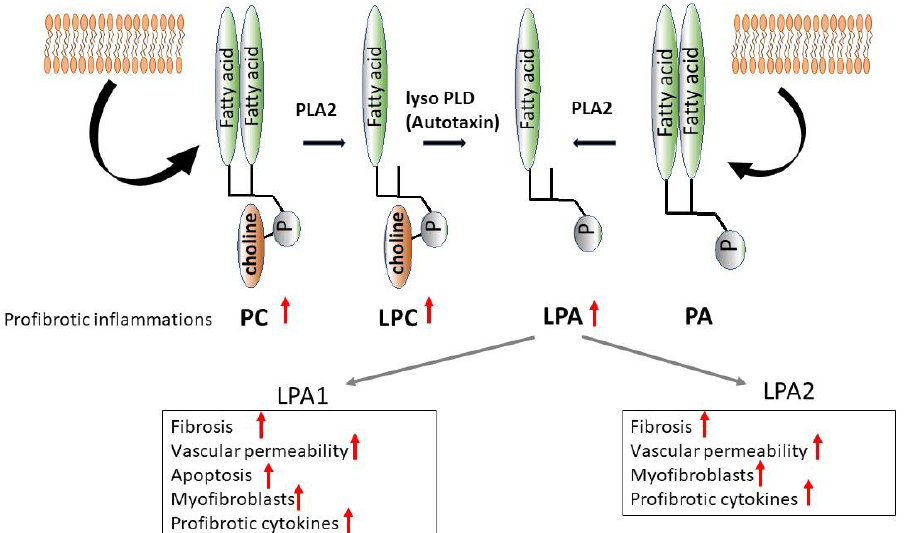
Figure 3. LPA pathway in fibrotic lung diseases. A representative pathway for lysophosphatidic acid (LPA) production is shown here. Glycerophospholipids, such as phosphatidylcholine (PC) and phosphatidylethanolamine (PE), are converted by phospholipase A2 (PLA2) into lysophosphatidylcholine (LPC). LPC is then converted by lysophospholipase D (lysoPLD: Autotaxin: ATX) into LPA. Another pathway involves the formation of lysoPLD/ATX from phosphatidic acid (PA). Later, the signals are transduced to the LPA receptors (LPA1/LPA2), resulting in the manifestation of physiological activity related to pulmonary fibrosis.